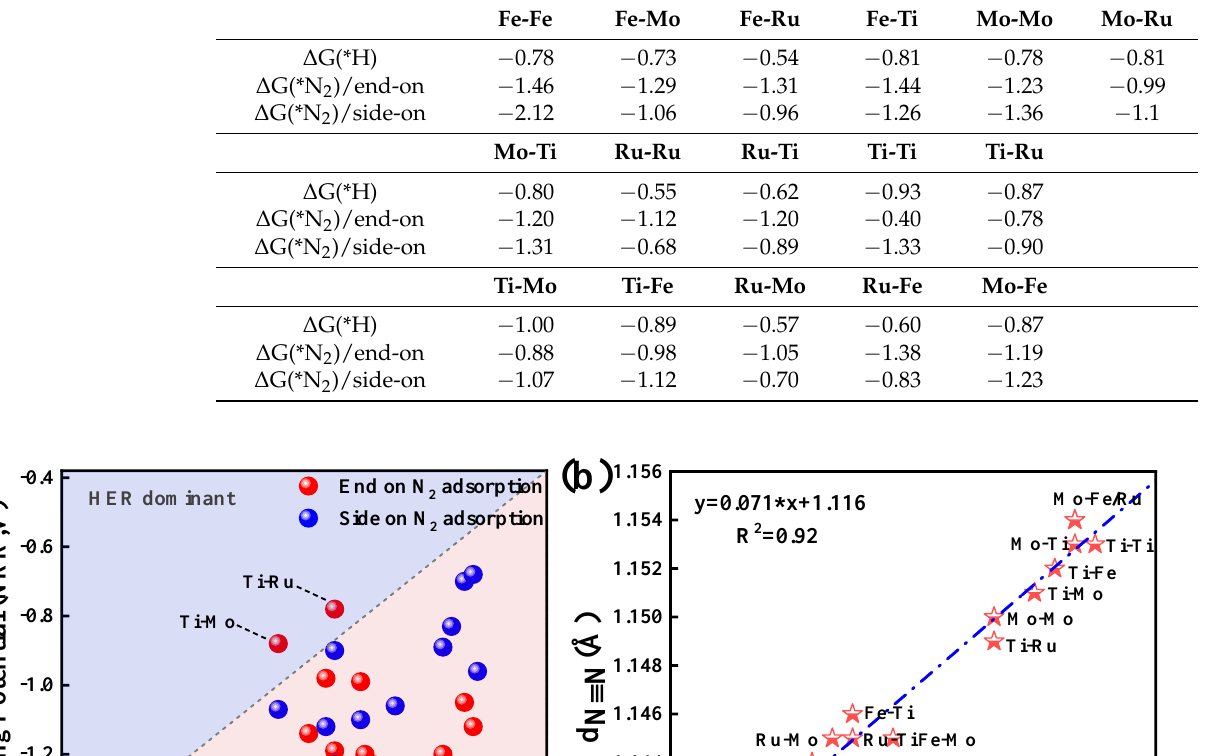
Table 1. Calculated free energy changes for *H ( ∆ G (*H)) and *N 2 ( ∆ G (*N 2 )) on 16 TM 1 -TM 2 @V B -BN catalysts. TM 1 is the adsorption site for N 2 .